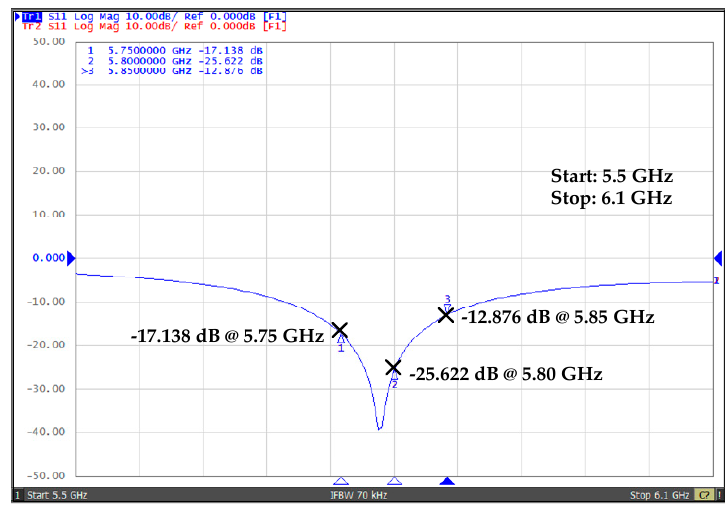
Figure 20. RF external on board impedance matching measurement result.